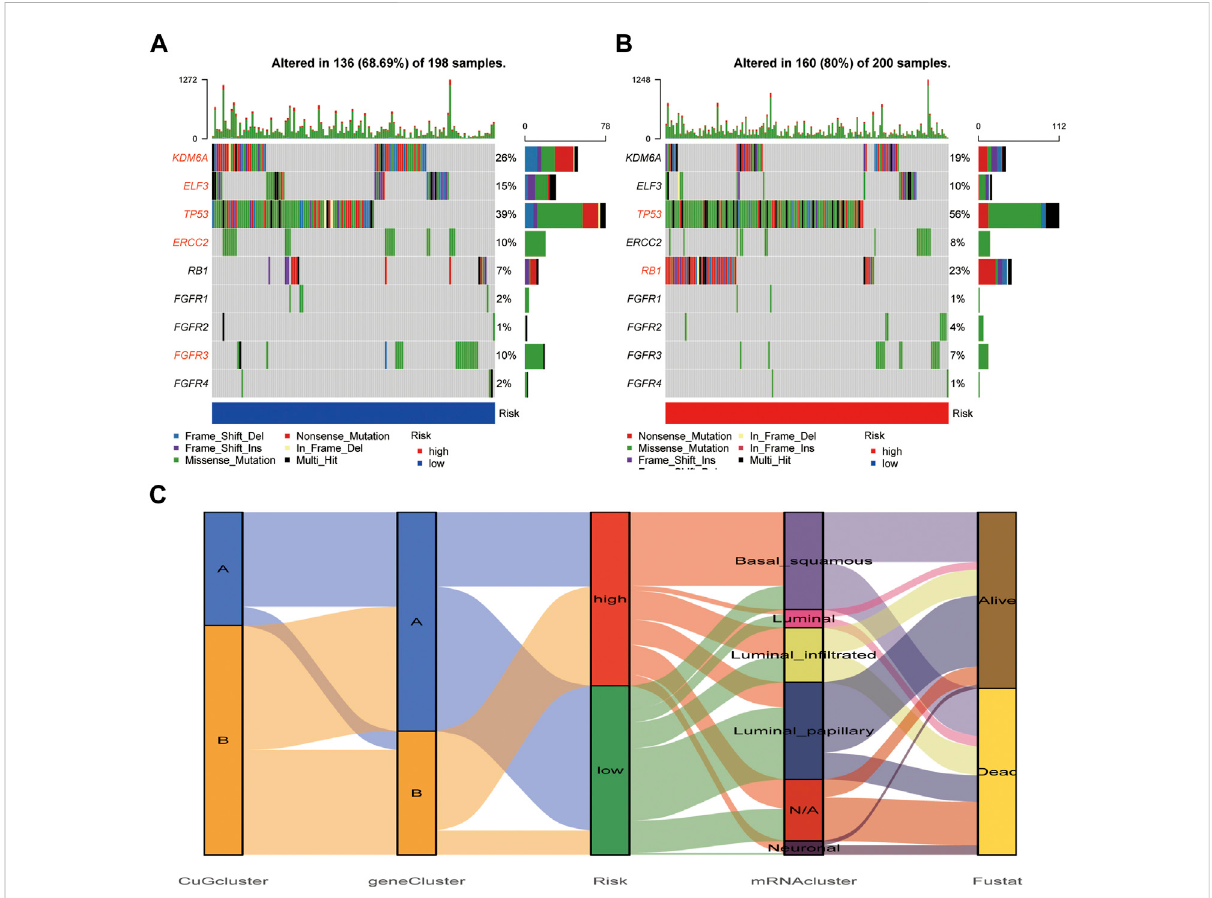
FIGURE 8 Mutation difference between cuproptosis risk groups. (A,B) The waterfall plot showed the mutations of most-concerned genes in BLCA accordingtothepreviousresearchinthelow-risk group (A) andhigh-riskgroup (B) .Thecharacteristicgenesineachgroupwereemphasizedinred. (C) The alluvial diagram showed the relationship of cuproptosis risk groups and 2017 TCGA clustering. Abbreviations: BLCA, bladder cancer; TCGA, The cancer genome